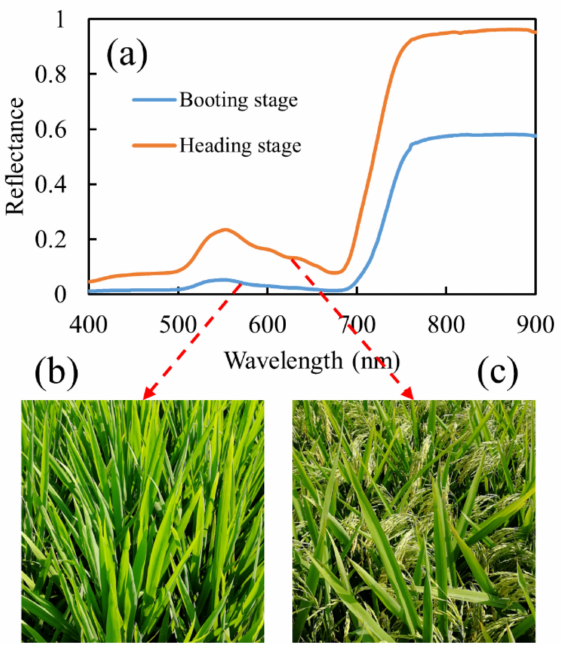
Figure 4. Spectra and field photos of rice at different stages: ( a ) spectral curves of rice at different stages; ( b ) actual view of rice at booting stage; ( c ) actual view of rice at heading